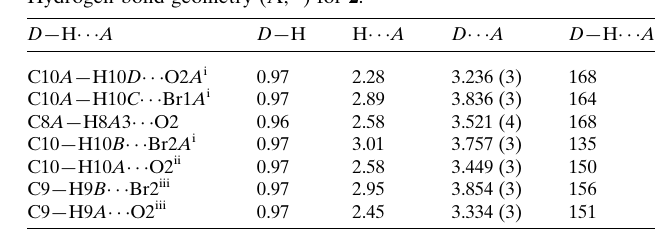
Table 2 Hydrogen-bond geometry (A˚ , (cid:3) ) for 2 .